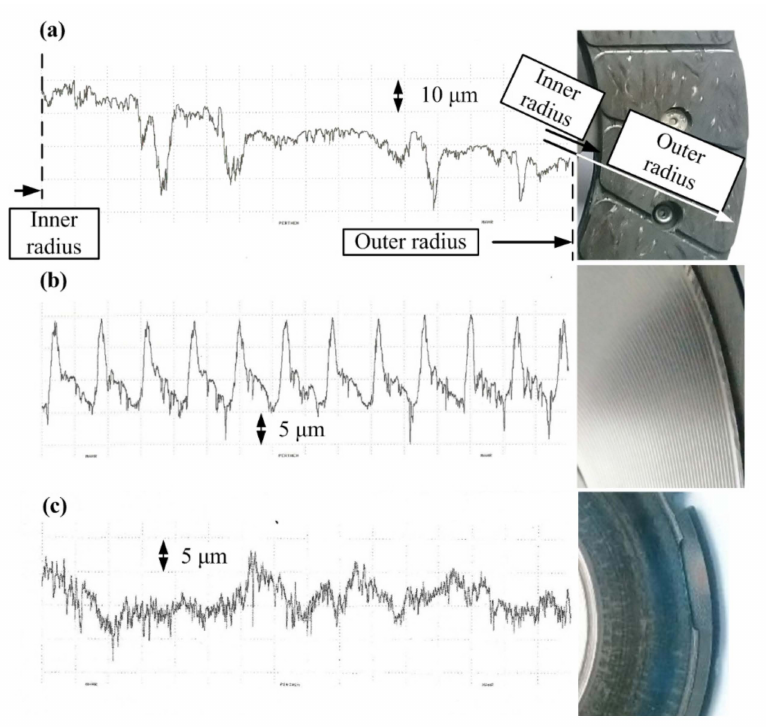
Figure 2. Surface roughness of friction plate ( a ), and unused ( b ) and worn-down pressure plate ( c